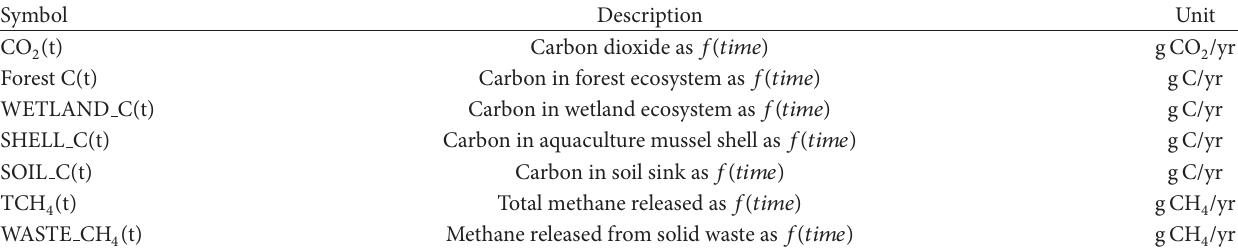
Table 2: State variables of the model, all expressed as tons of carbon on Gouqi Island as 𝑓(𝑡𝑖𝑚𝑒) .